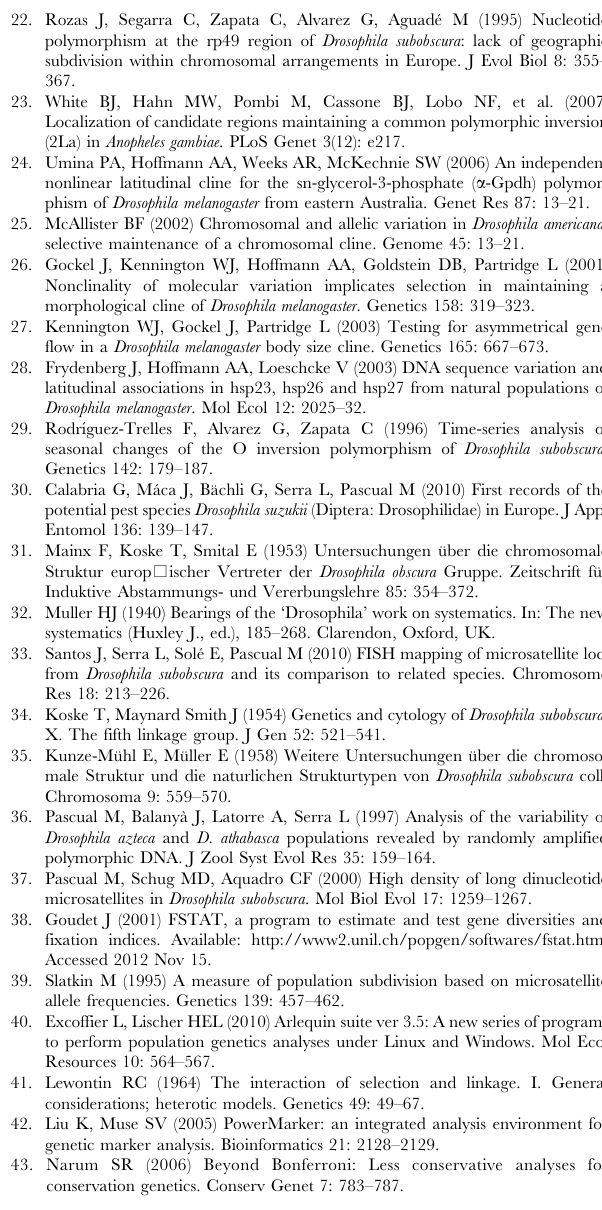
Table S5 Microsatellite allele frequencies in